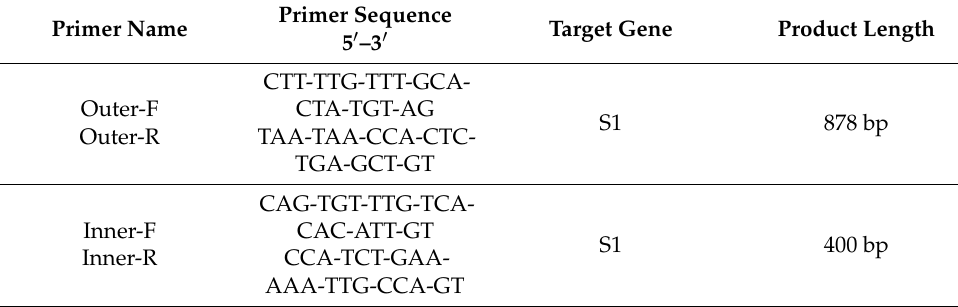
Table 2. PCR primers and PCR